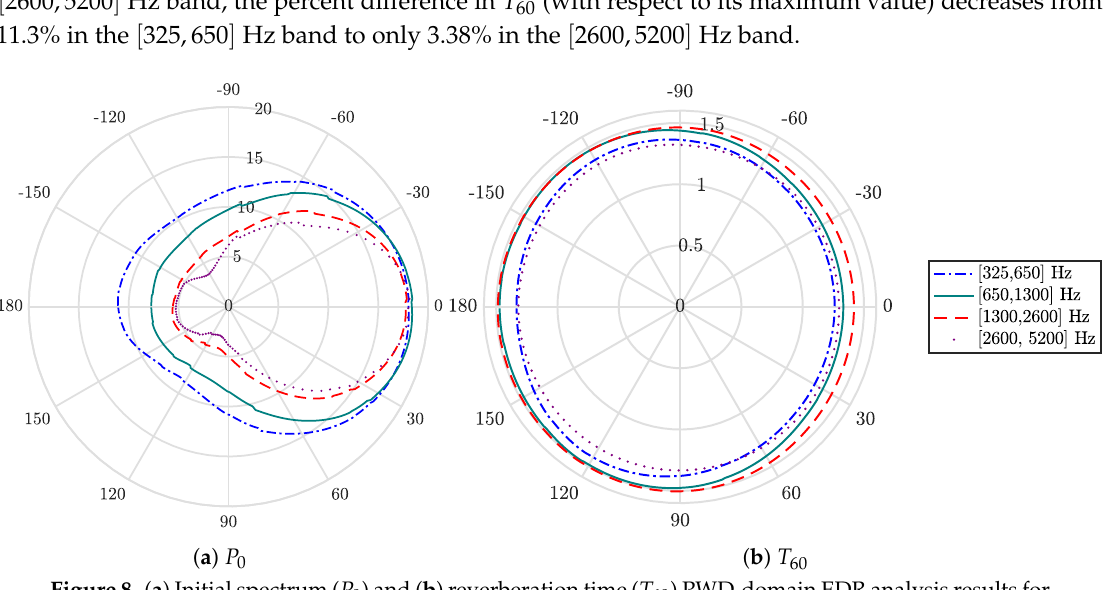
Figure 8. ( a ) Initial spectrum ( P 0 ) and ( b ) reverberation time ( T 60 ) PWD-domain EDR analysis results for the directional room impulse responses (DRIR) measured in the neo-Gothic chapel at the Dominicans of Haute-Alsace cultural center, averaged over four frequency bands (and once again projected onto the azimuthal plane by cubic Hermite spherical interpolation). Radii represent ( a ) dB and ( b ) seconds.